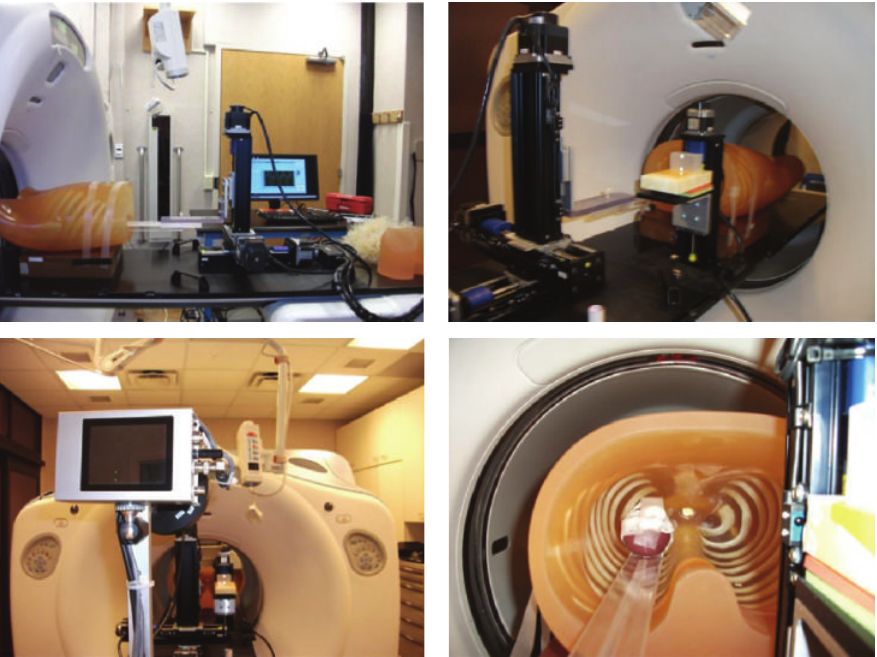
Figure 2: Experimental setup for validating MPSL-based motion and volume quantification using anthropomorphic chest phantom and the Washington University 4D motion